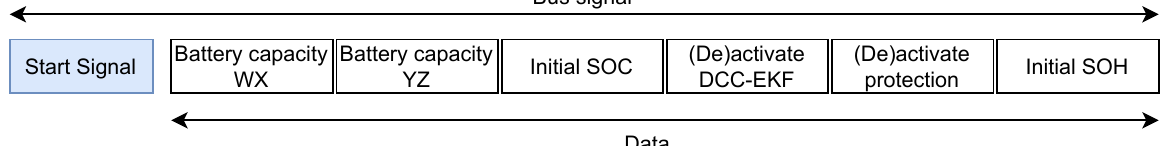
Figure 6. Data 1—Master to slave microcontroller bus signal.